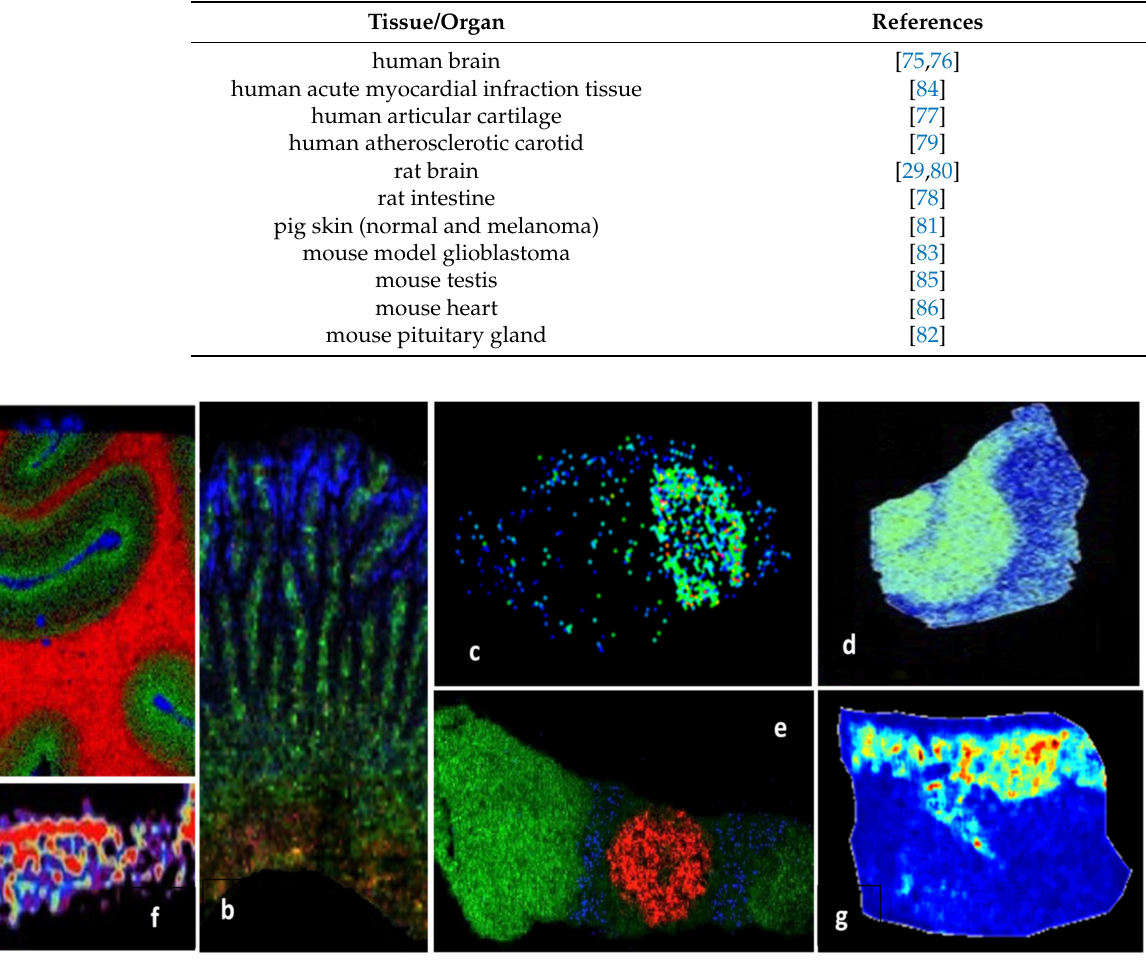
Figure 4. MALDI-MSI molecular pictures obtained by MALDI tandem mass spectrometry imaging for in situ identification of proteins: ( a ) Human visual cortex, myelin basic protein (red), neu- romodulin (green), and hemoglobin β (blue), MALDI-LTQ-Orbitrap instrument [75]; ( b ) rat small intestine, endogenous protein biomarkers in lamina propria (green), epithelium (blue), and submucosal layer (red), MALDI-ToF/ToF instrument [78]; ( c ) mouse model glioblastoma 60S ribosomal protein L34, MALDI-ToF/ToF instruments [83]; ( d ) AD hippocampal section, MUC19 isoform 5